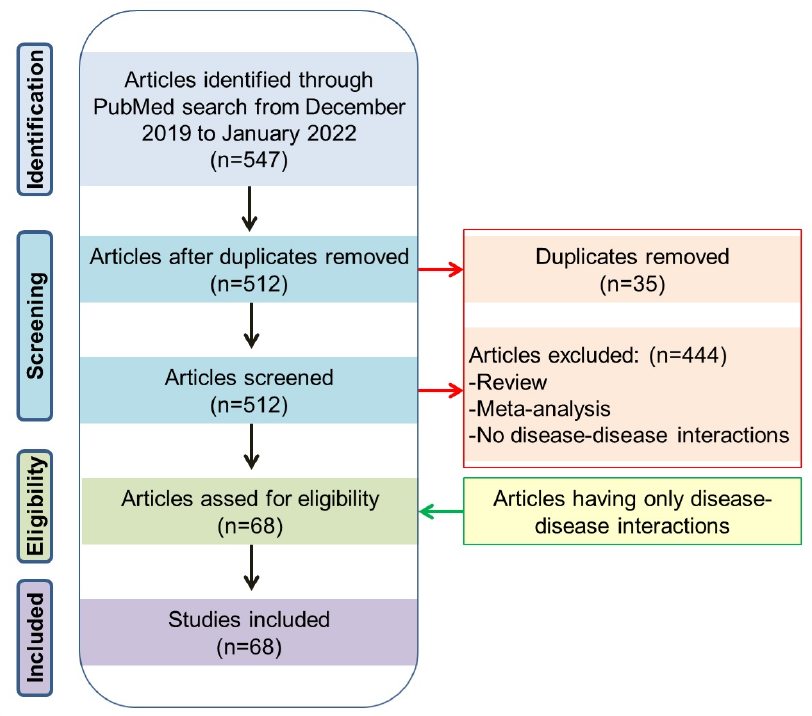
Figure 2. PRISMA flow diagram of the literature search and article selection to develop the key sections (direct association and disease–disease interactions between a congenital anomaly or genetic disease and COVID-19) of this review.